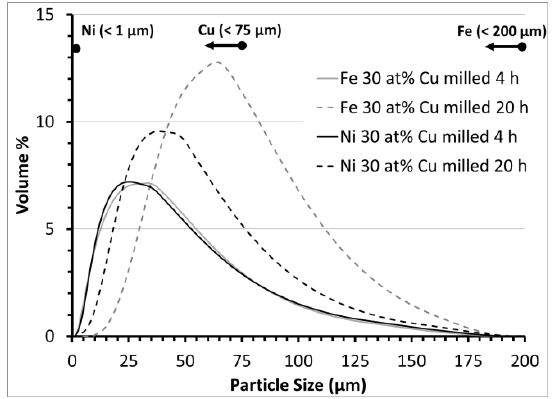
Figure 5. Particle size analysis reveals an increase in size after longer milling time. Starting sizes of the elemental powder sizes are labeled at the top of the